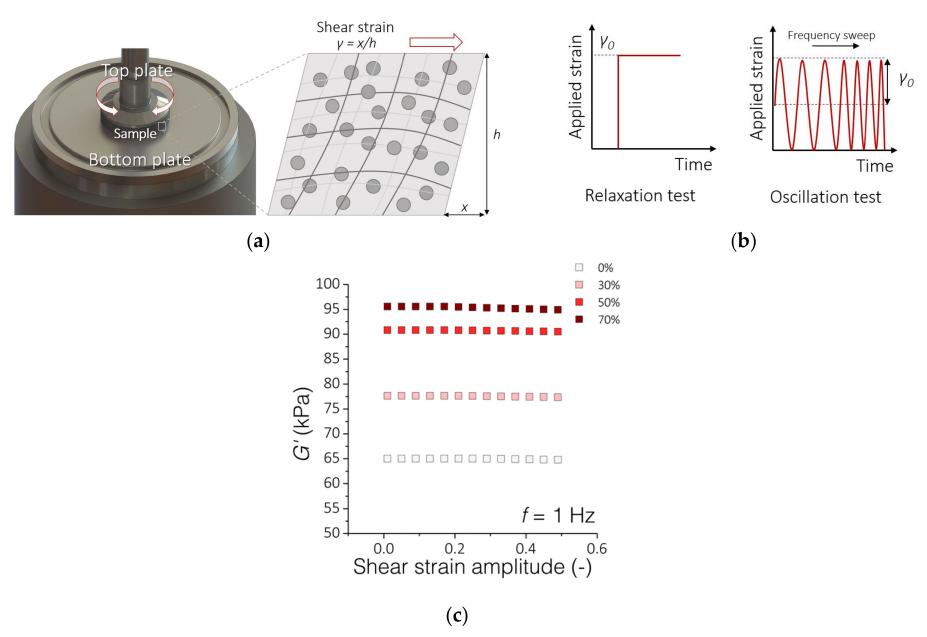
Figure 2. Rheological experimental setup. ( a ) Measuring system for testing the rheological properties of PDMS-MPs composites; ( b ) The scheme of material deformation overtime during the performed rheological tests; ( c ) Results of oscillatory tests with variable amplitude of shear deformations and a constant frequency f = 1 Hz. The graph shows the range of linear viscoelasticity up to about 20% of the deformation